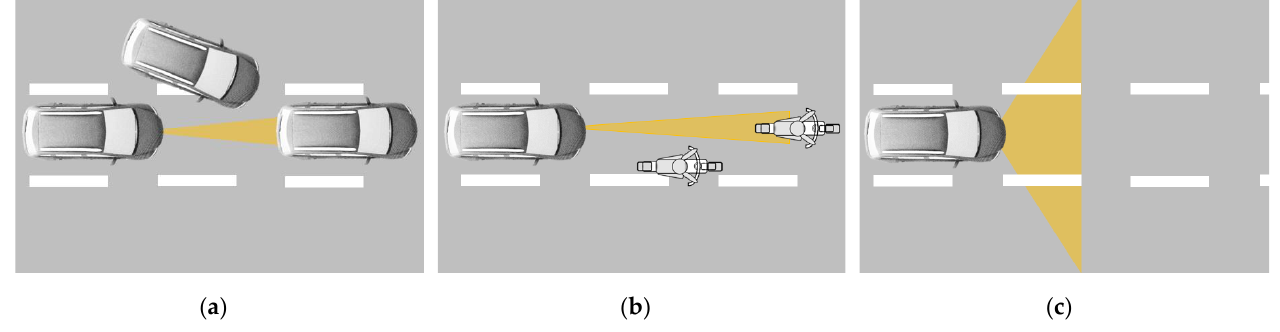
Figure 9. Illustration of exemplary problem situations due to a narrow FOV: ( a ) late detection of a cut-in vehicle; ( b ) offset of a motorbike; and ( c ) detection of three lanes.